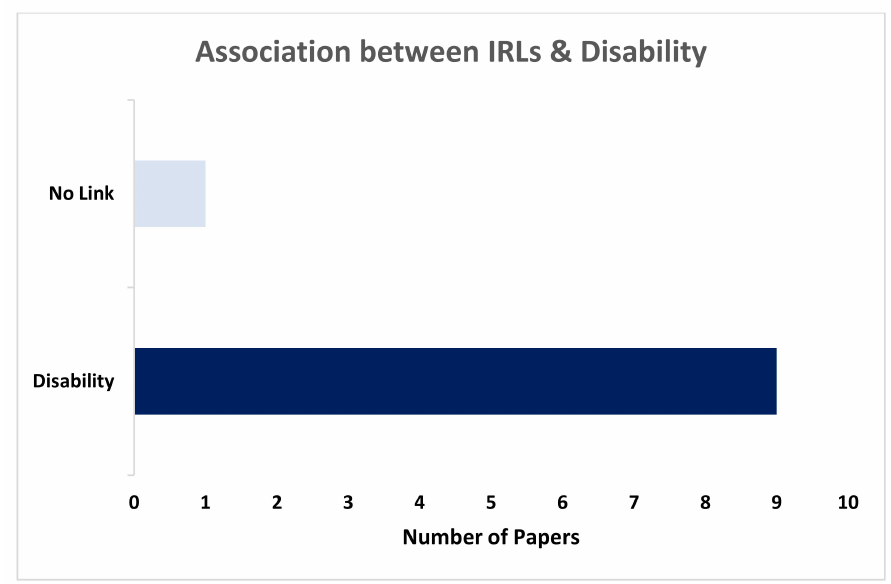
Figure 4. Illustrates the number of papers that found a link between IRLs presence and concurrent